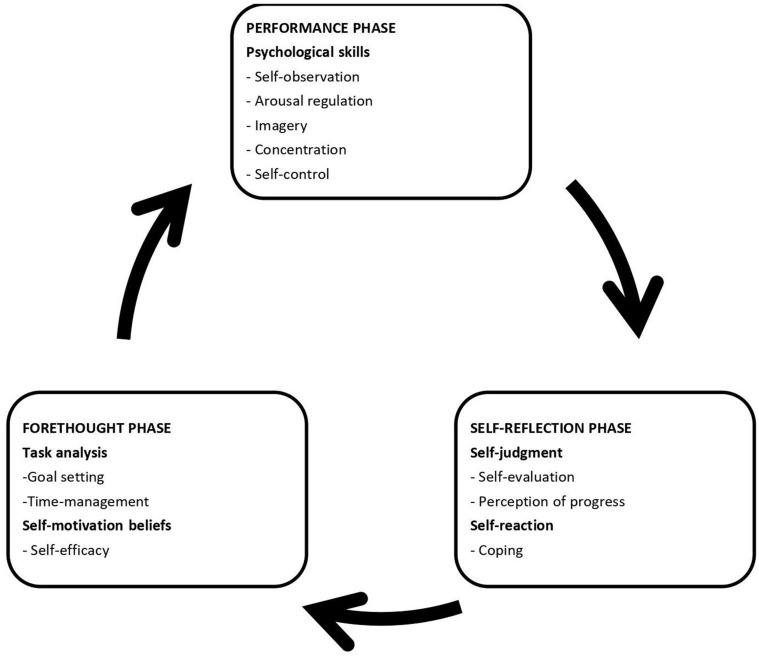
Zimmerman’s 3-phase self-regulated learning cyclical model adapted for music by Hatfield et al. (2017).